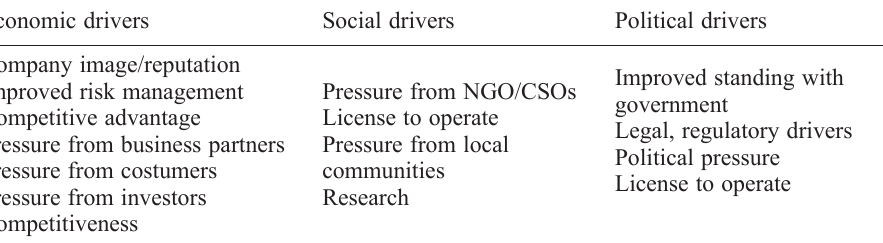
Table 1. The drivers of corporate social